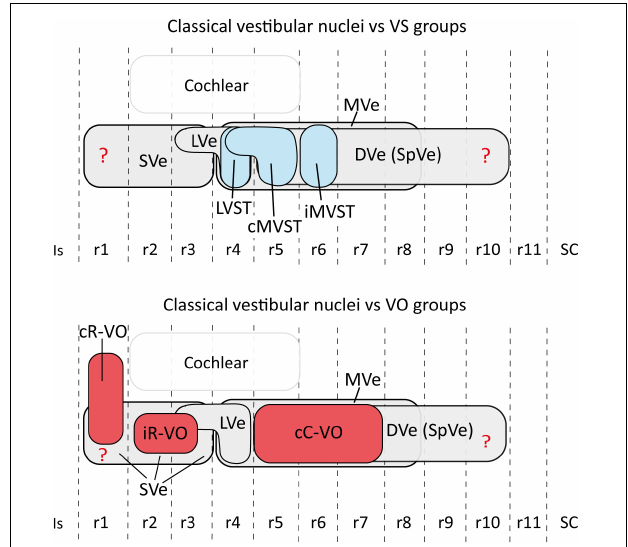
FIGURE 6 | Schematic representation of the relationship between the hodologically defined vestibular neuron groups [ (upper panel) vestibulospinal groups in blue; (lower panel) vestibulo-ocular groups in red] and the classical cytoarchitectonic nuclei (in gray) in the mouse. The view is from the lateral aspect. Interhombomeric limits are indicated with dash lines. Rostral is to the left and dorsal is up. Note that, despite the appearance that some groups overlap a lot (especially cC-VO with cMVST and iMVST), in 3D the overlap is minimal (aside from specific examples of overlap described in the text). The rhombomeric origins of the vestibulospinal and vestibulo-ocular neuron groups are based on Pasqualetti et al. (2007); Di Bonito et al. (2015); Lunde et al. (2019). Correlation between the rhombomeric maps of vestibular projection neurons and classical cytoarchitectonic vestibular nuclei is tentative [see proposals in Pasqualetti et al. (2007)]. cC-VO, contralateral vestibulo-ocular group; cMVST, contralateral medial vestibulospinal group; DVe (SPVe), descending (spinal or inferior) vestibular nucleus; iMVST, ipsilateral medial vestibulospinal group; iR-VO, ipsilateral vestibulo-ocular group; Is, isthmus, LVe, lateral vestibular nucleus; LVST, lateral vestibulospinal group; r, rhombomere; SC, spinal cord; SVe, superior vestibular